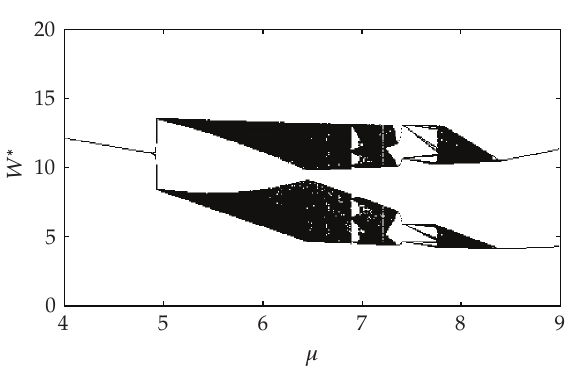
Figure 7: Bifurcation diagram for μ ∈ (cid:3) 4 , 9 (cid:4) .